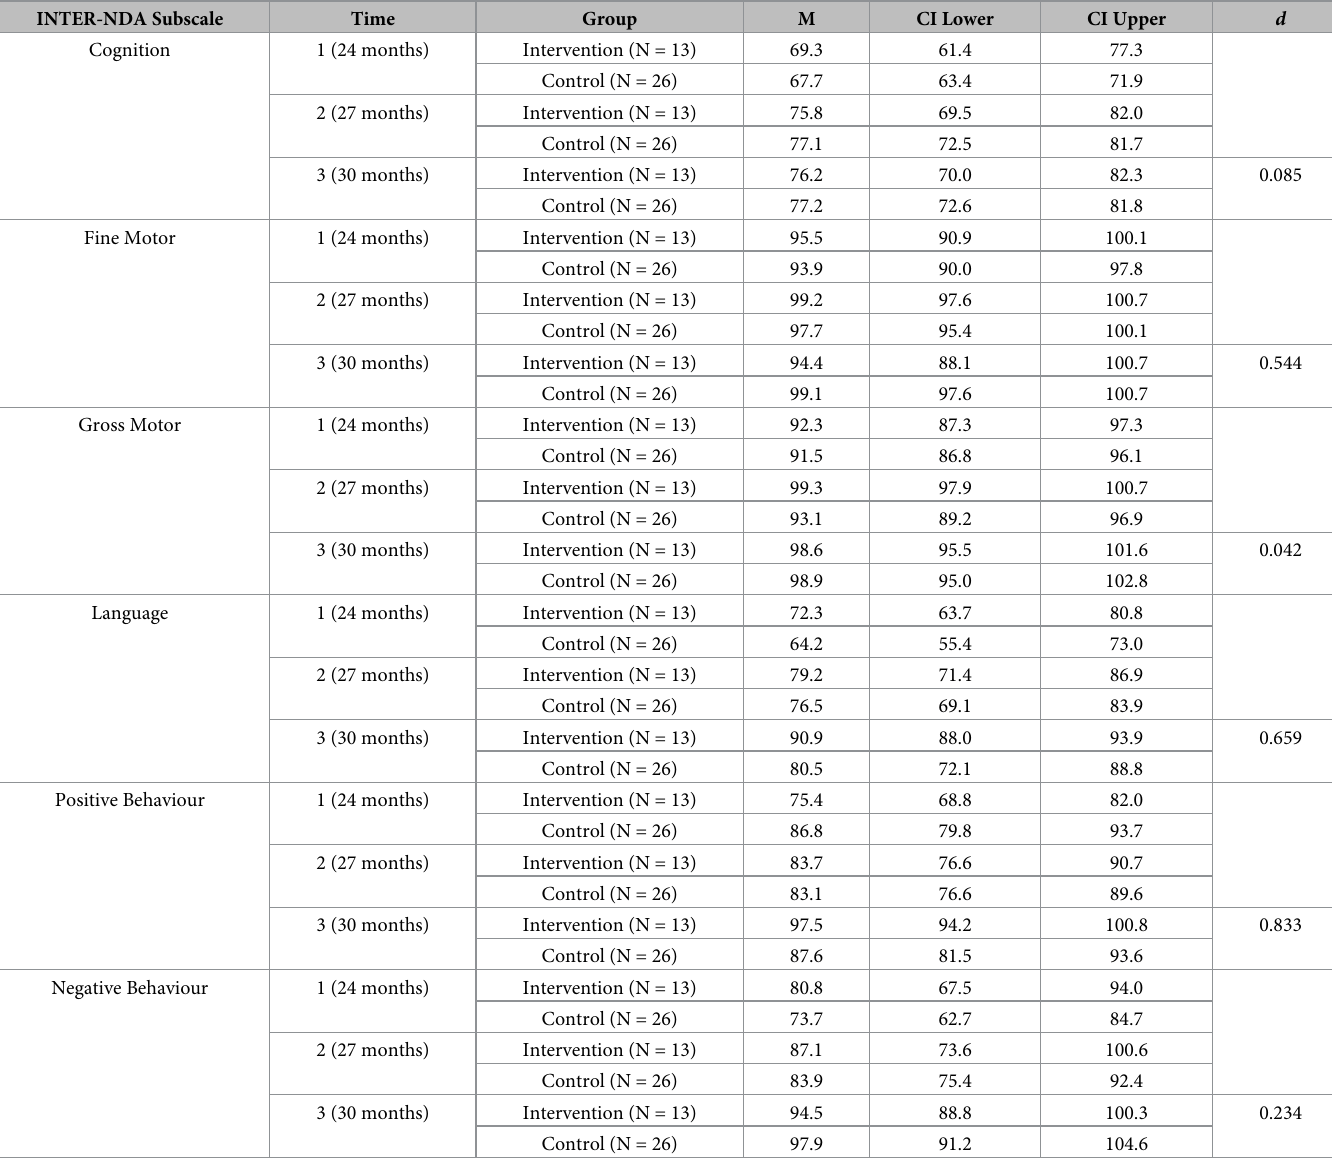
Table 3. Estimated Marginal Means of Child Development Outcomes Derived from the GEE Models by Group and Effect Sizes. INTER-NDA Subscale